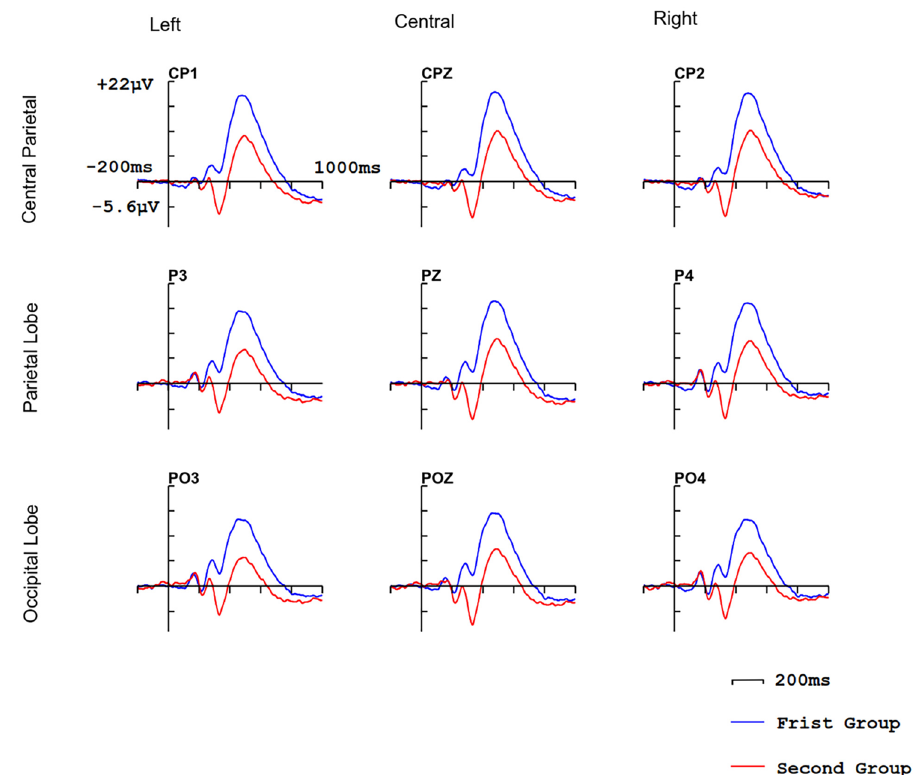
Fig. 5 ERP waves on CP1, CPz, CP2, P3, Pz, P4, PO3, POz, PO4 (electrodes that are used to analyze P3b component) of the first comparison group (first group and second